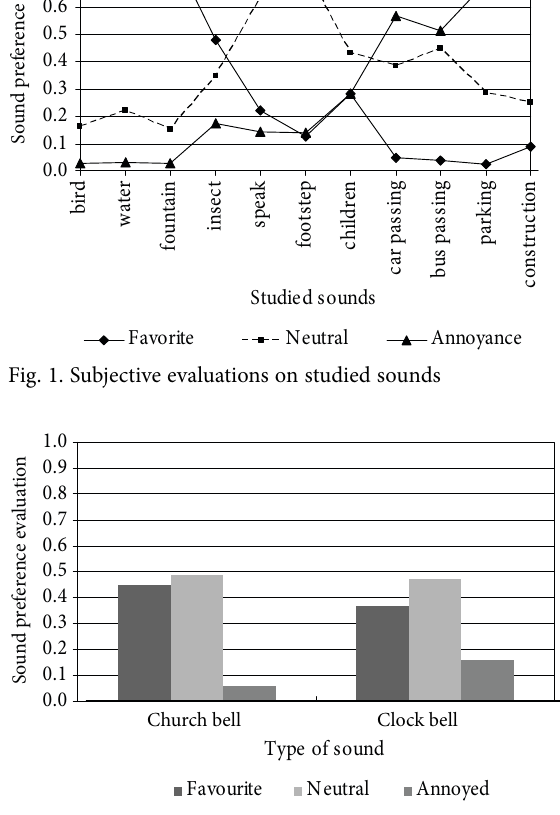
Fig. 2. Comparison of the subjective evaluation of church bell and clock